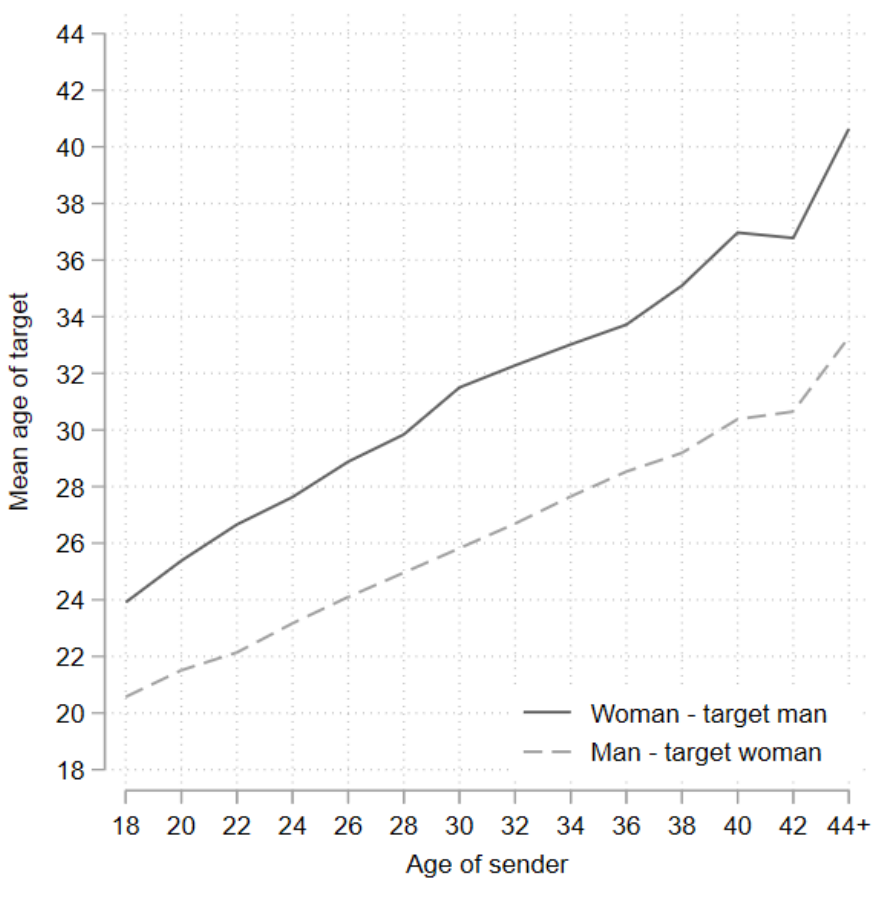
Figure 1 : Mean age contacted by men and women, by their